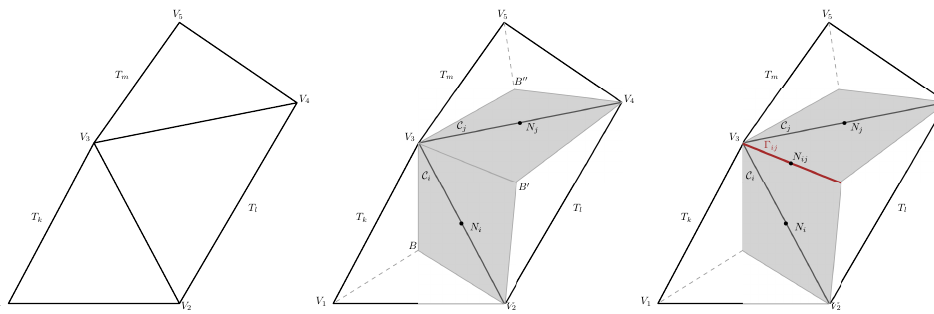
Figure 1. Primal and dual two-dimensional elements. ( Left ): primal elements T k , T l , T m with vertex V n , n = 1, . . . ,5. ( Center ): dual interior cells C i , C j (highlighted in grey); white triangles correspond to boundary cells. ( Right ): edge Γ ij (in red) shared by the interior dual elements C i and C j